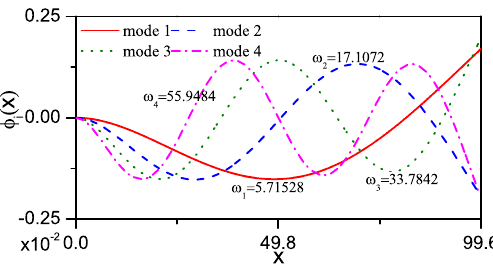
Figure 3. The planar mode shapes and natural frequencies of the elastic beam.